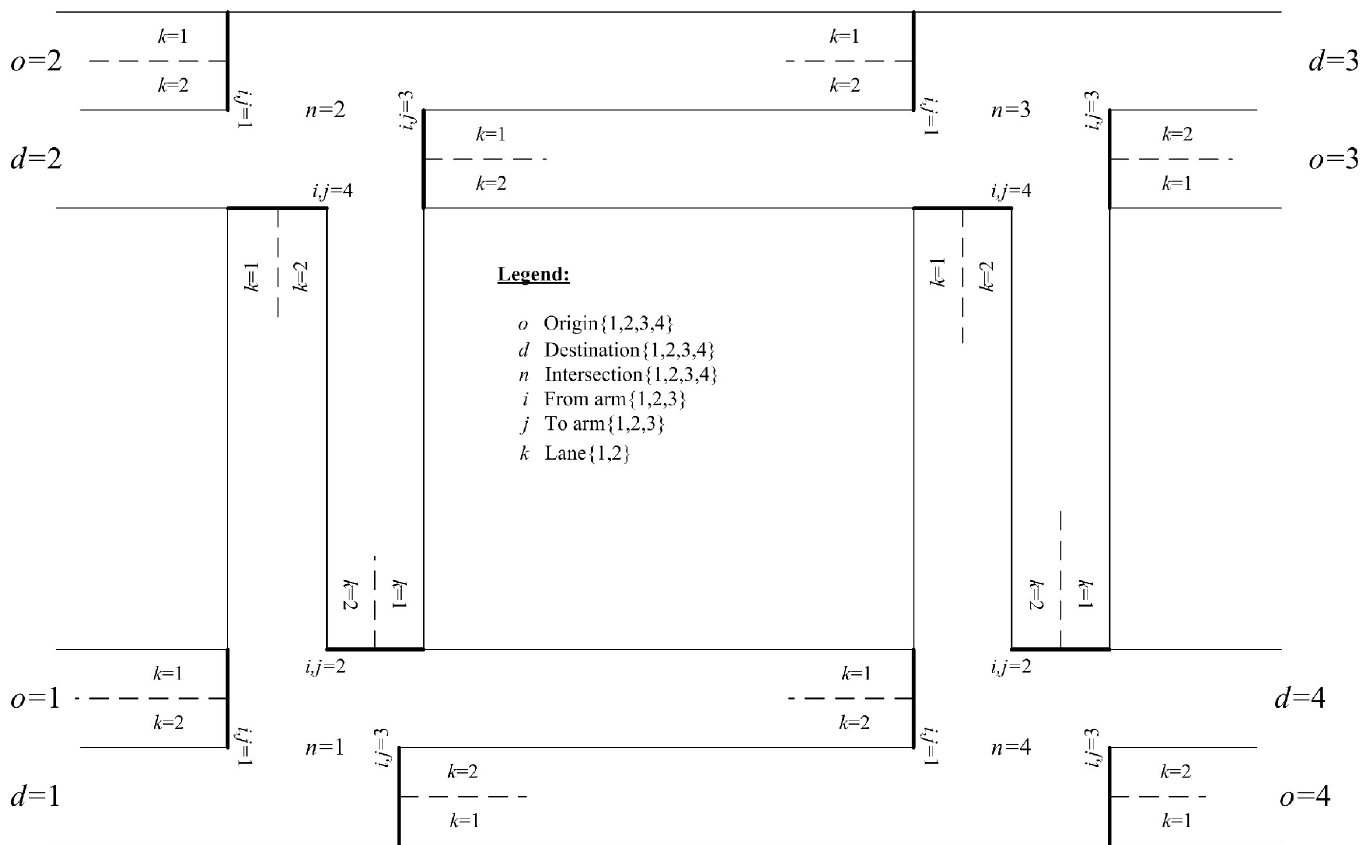
Fig 7. Settings of the case study signal-controlled network with four signalized intersections.